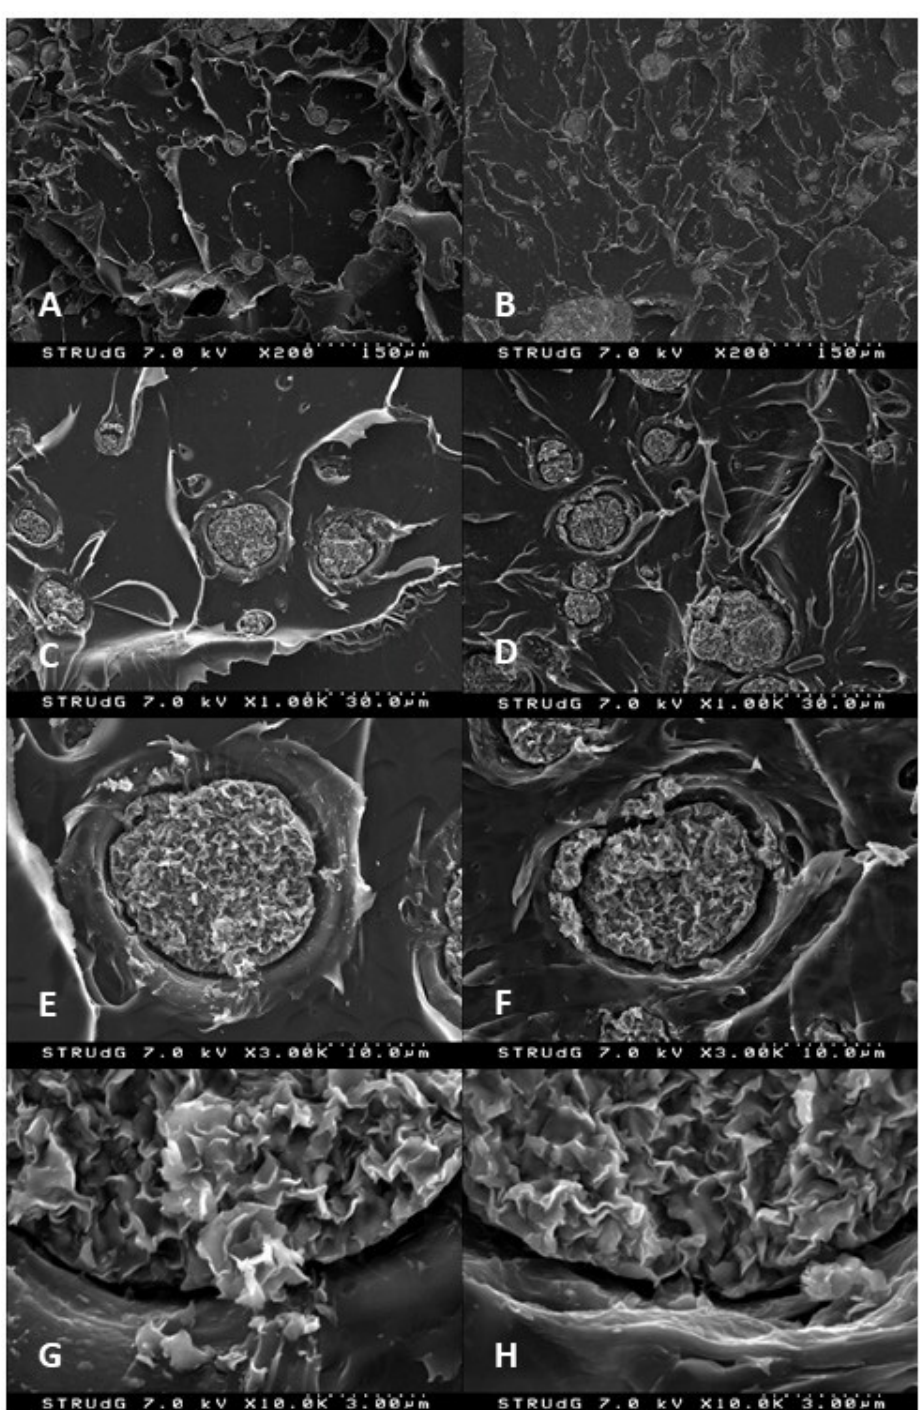
Figure 2. SEM micrographs of PLA+4%N nancomposites prepared with direct melting (left column) and masterbatch methodology (right column) at different magnifications: ( A , B ) by ×200; ( C , D ) by ×1000, ( E , F ) by ×3000; and ( G , H ) by ×10,000.